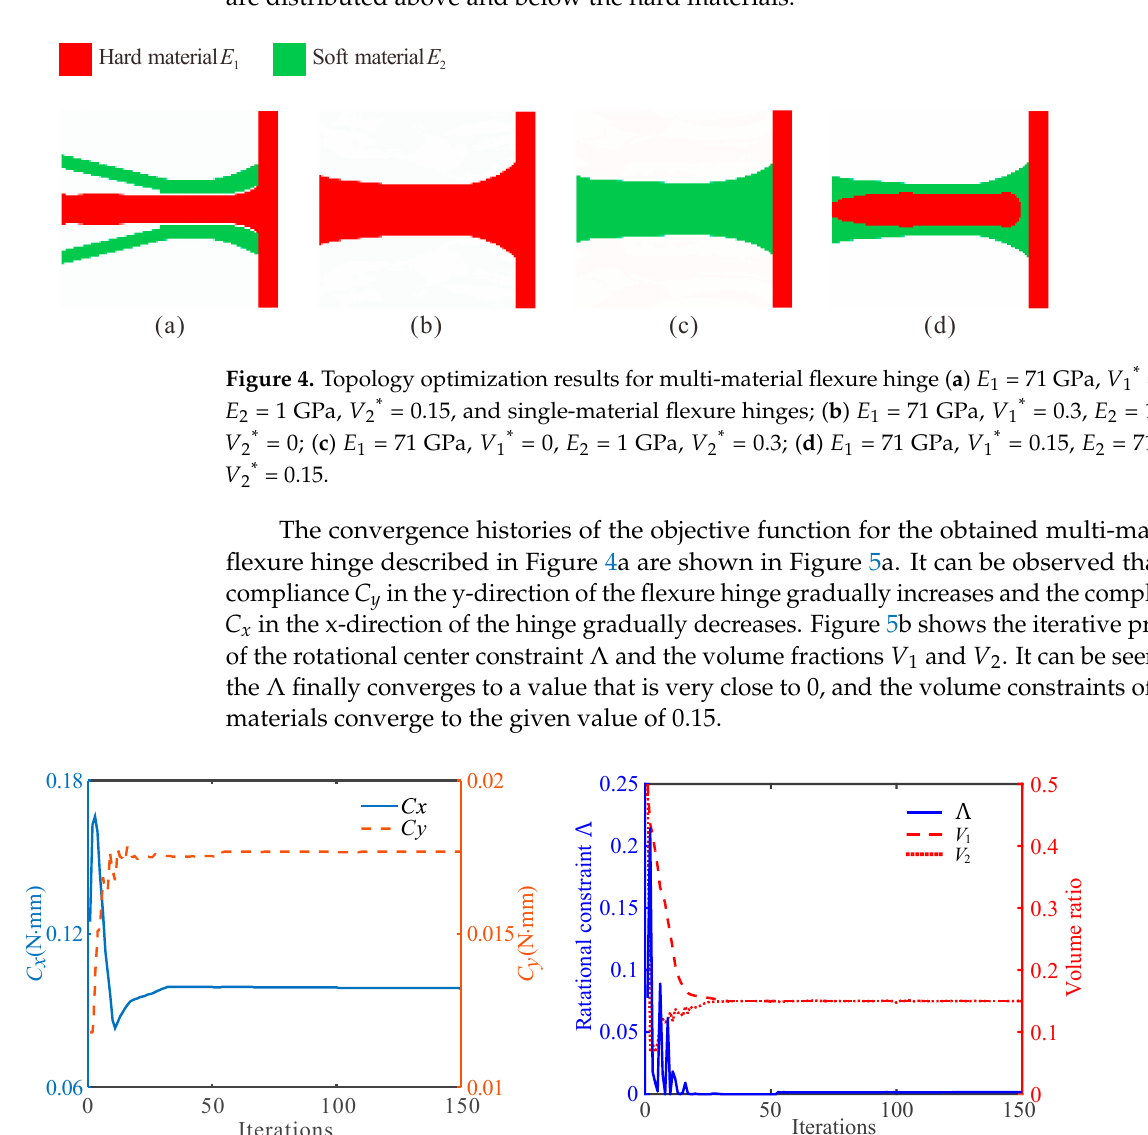
Figure 5. Iterative process for topology optimization of multi-material flexure hinges. ( a ) The con- vergence histories of the objective function, ( b ) the convergence histories of the rotational center constraint Λ and the volume fractions V 1 and V 2 .